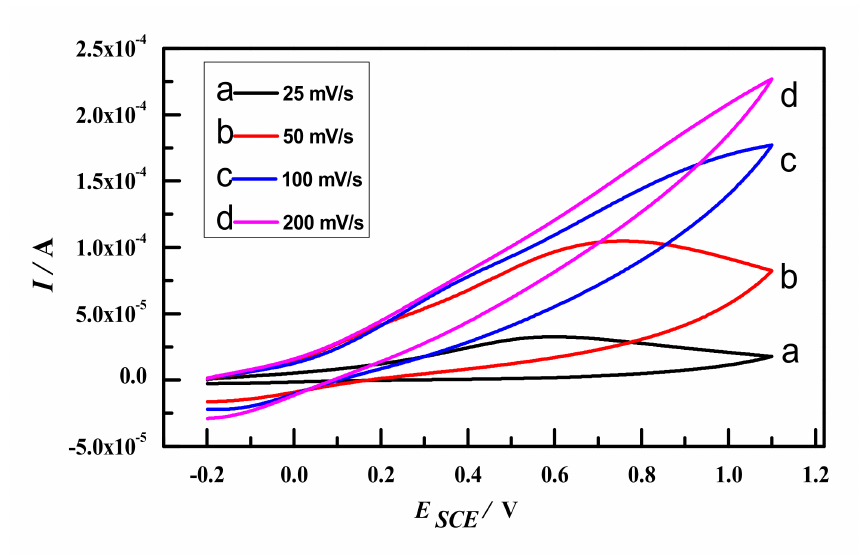
Figure 9. CV curves of PACHA coated gold electrodes in 0.06 M NaOH + 5 M CH 3 OH at 25, 50, 100, and 200